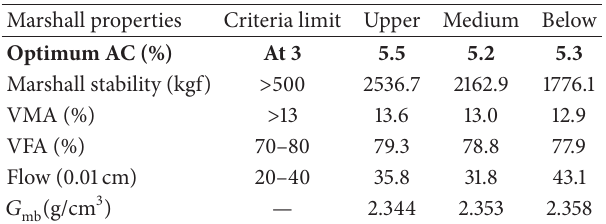
Table 1: Marshall test results at the optimum asphalt